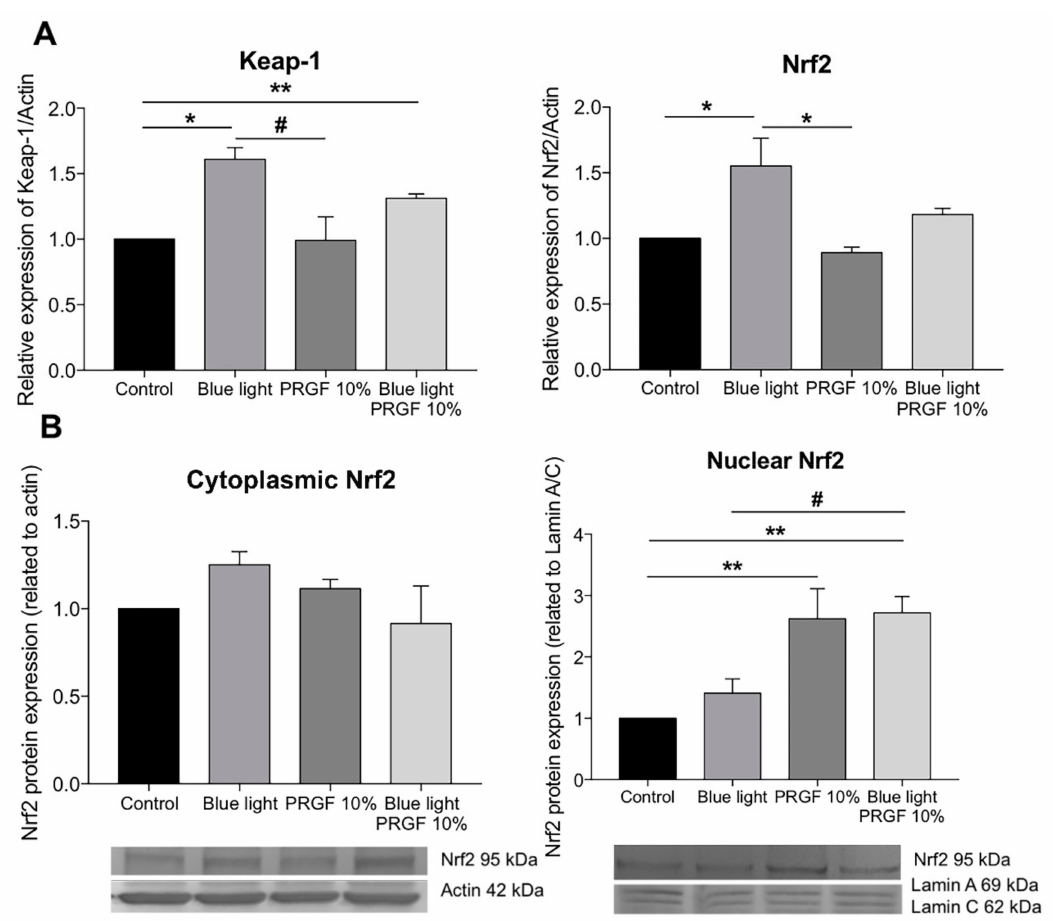
Figure 6. ARPE19 cell cultures ( n = 4). ( A ) Nrf2 and Keap1 gene expression related to actin, blue light increased the expression of both genes but PRGF reduced it; ( B ) Nrf2 protein expression, blue light slightly increased the expression of cytoplasmic Nrf2 as compared with the control, nuclear Nrf2 increased when cells were treated with PRGF. Statistical analysis: One-way ANOVA, Tukey multiple comparison test, * p < 0.05, ** p < 0.005, and # p <